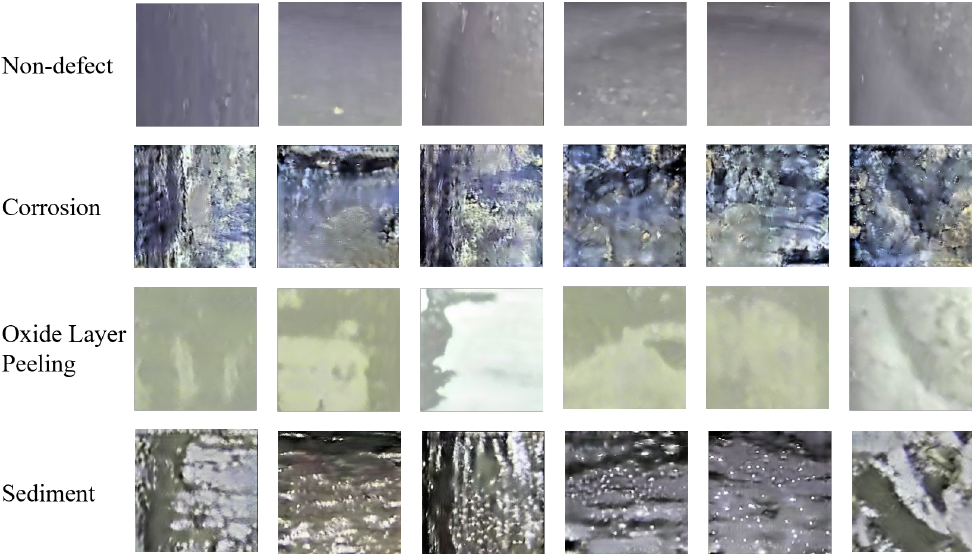
Figure 11. The non-defect images in the original pipeline and the results generated by Cycle-GAN. The corresponding defect region N is generated by Cycle-GAN on the non-defect region, which is randomly selected on the images of the original dataset. In order to avoid